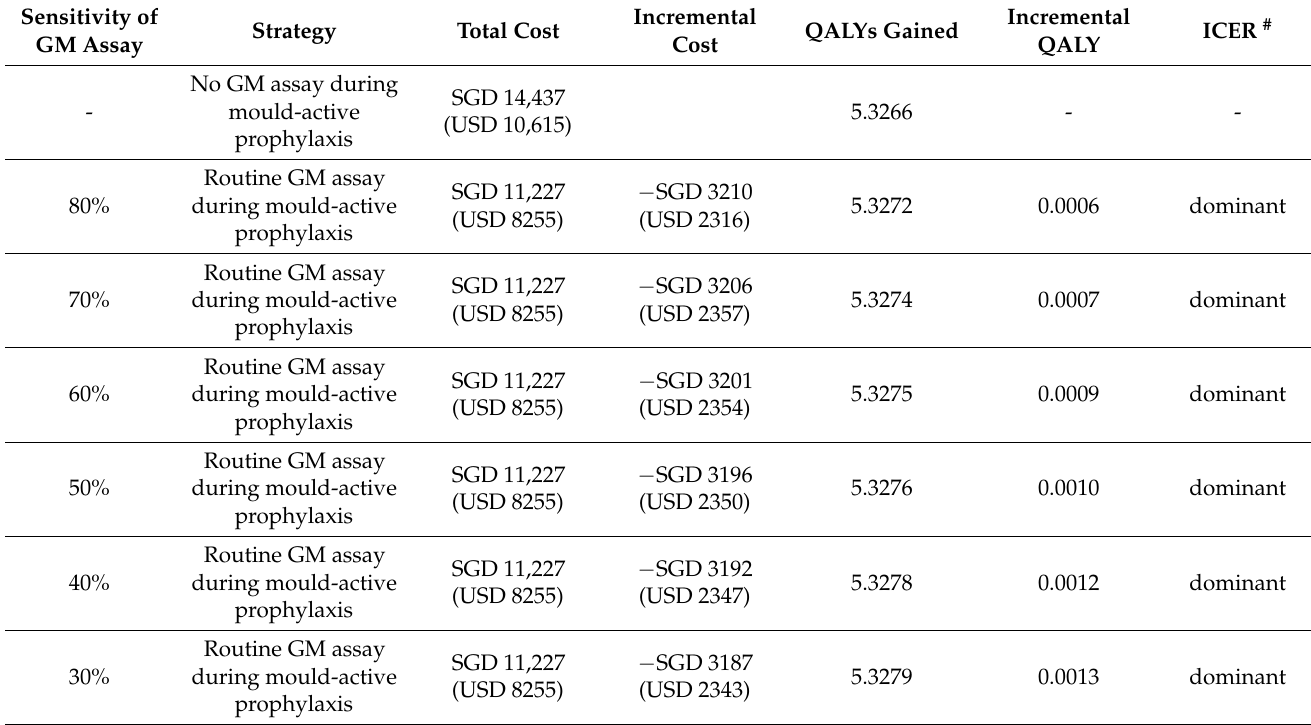
Table 4. Total cost, effectiveness, and incremental cost-effectiveness ratio when the sensitivity of serum galactomannan immunoassay decreased in patients receiving mould-active